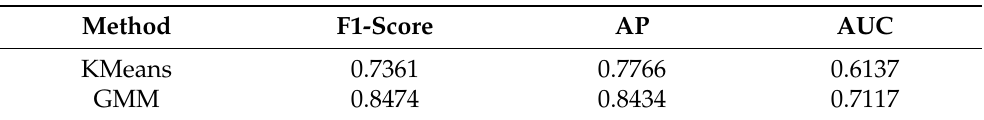
Table 2. Segmentation Comparison., F1-score, average precision (AP), and Area under the ROC curve (AUC).